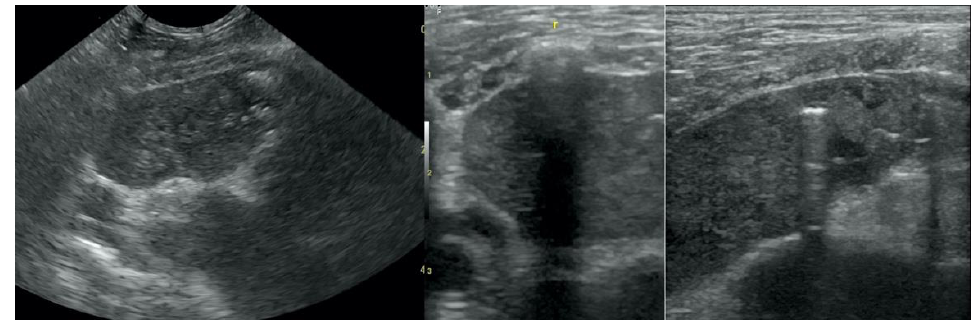
Figure 5. Hepatization without aeration in the course of pneumonia.